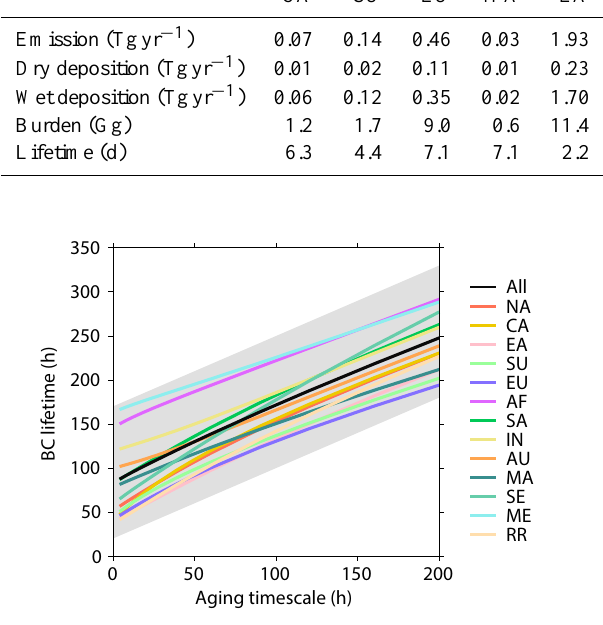
Figure 6. The lifetime of global BC (black) and tagged BC emitted from 13 source regions (colors) as a function of aging timescale. The top and bottom edges of the gray shading indicate a slope of